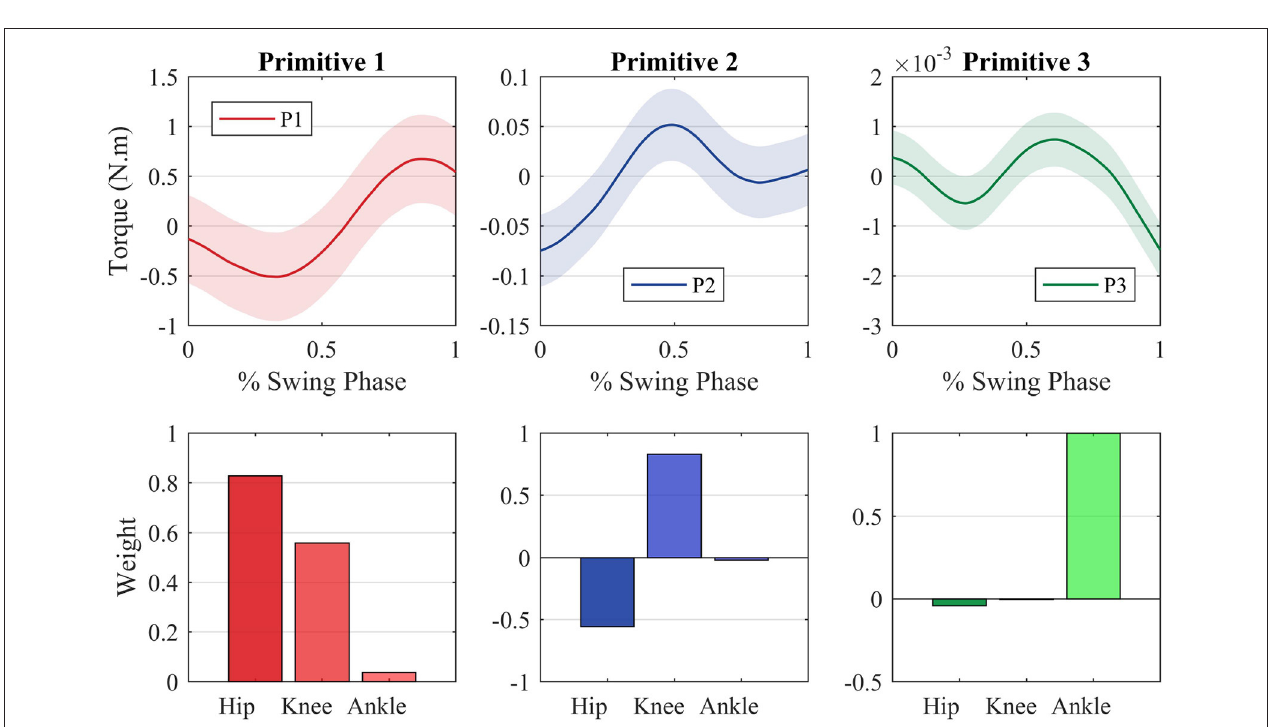
FIGURE 5 | Motor primitives extracted through the PCA method and the motor primitive weights regarding each joint. The joint torques can be reconstructed by making a weighted sum of each primitive with regards to each joint.